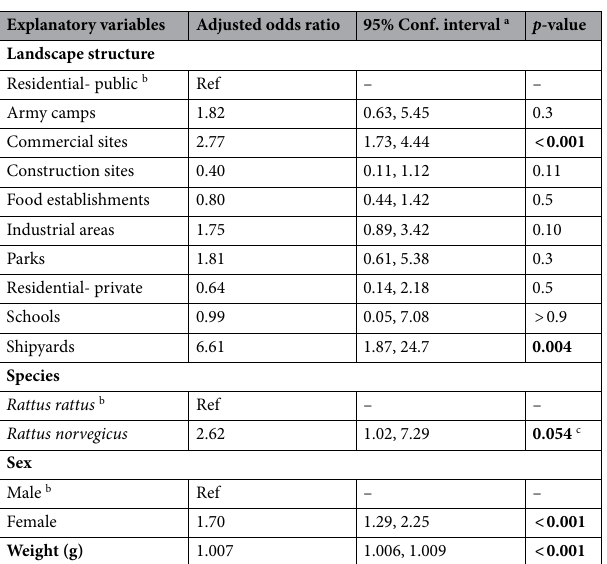
Table 5. Multivariable logistic regression model for Seoul hantavirus antibody detection in Rattus rattus and Rattus norvegicus . Significant values ( P < 0.05) are shown in bold. a 95% Confidence Interval. b Reference category. c Borderline statistical